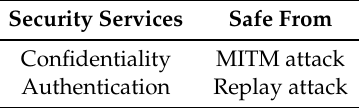
Table 1. Summary of the results in AVISPA